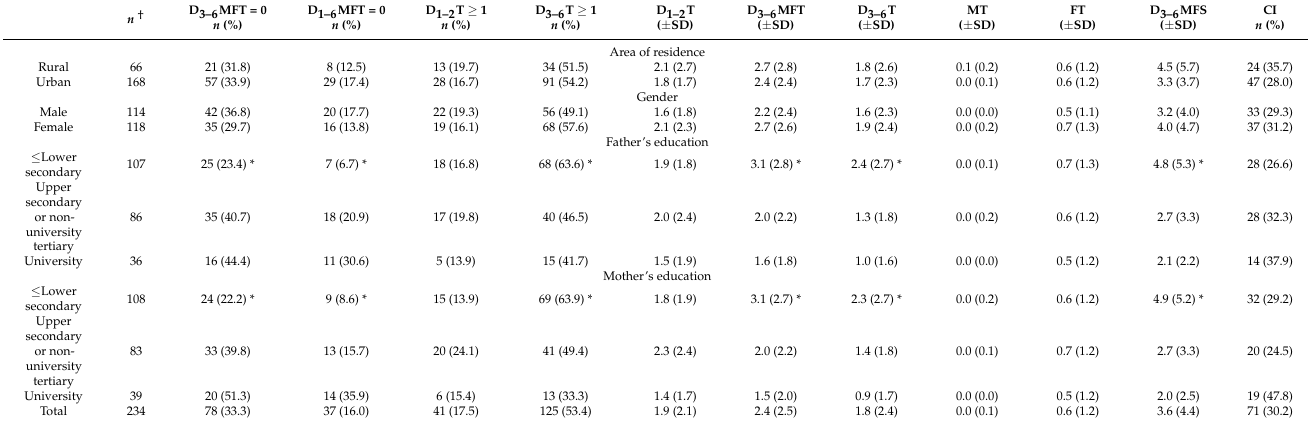
Table 2. Caries prevalence and caries experience of 12-year-old children of immigrant origin in Greece. Number of children ( n ), percentage of caries-free children on the D 3–6 MFT level (D 3–6 MFT = 0), percentage of caries-free children on the D 1–6 MFT level (D 1–6 MFT = 0), percentage of children with initial caries (D 1–2 T ≥ 1), percentage of children in need of restorative treatment (D 3–6 T ≥ 1), mean ICDAS 1–2 on the tooth level (D 1–2 T), mean D 3–6 MFT and its components (D 3–6 T, MT, FT), mean